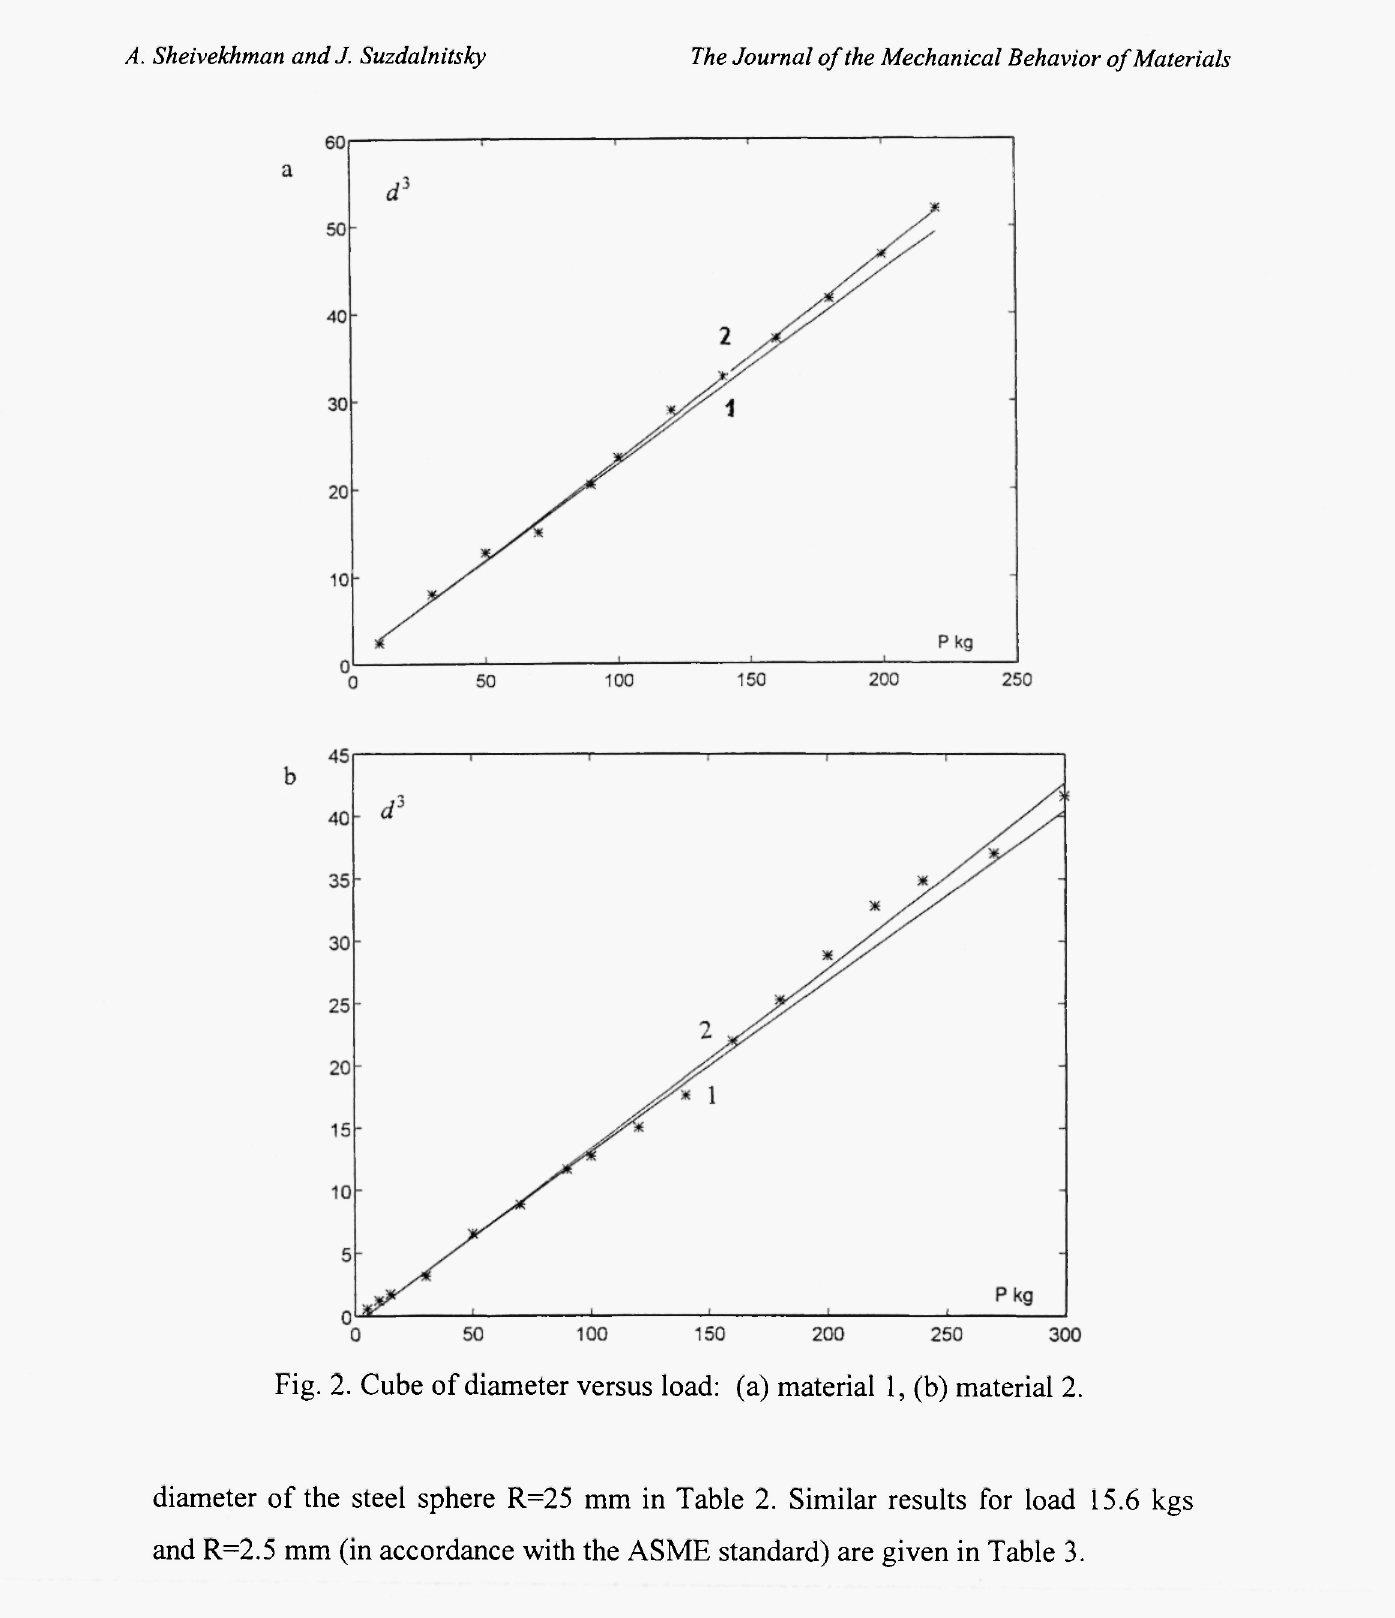
Fig. 2. Cube of diameter versus load: (a) material 1, (b) material 2.